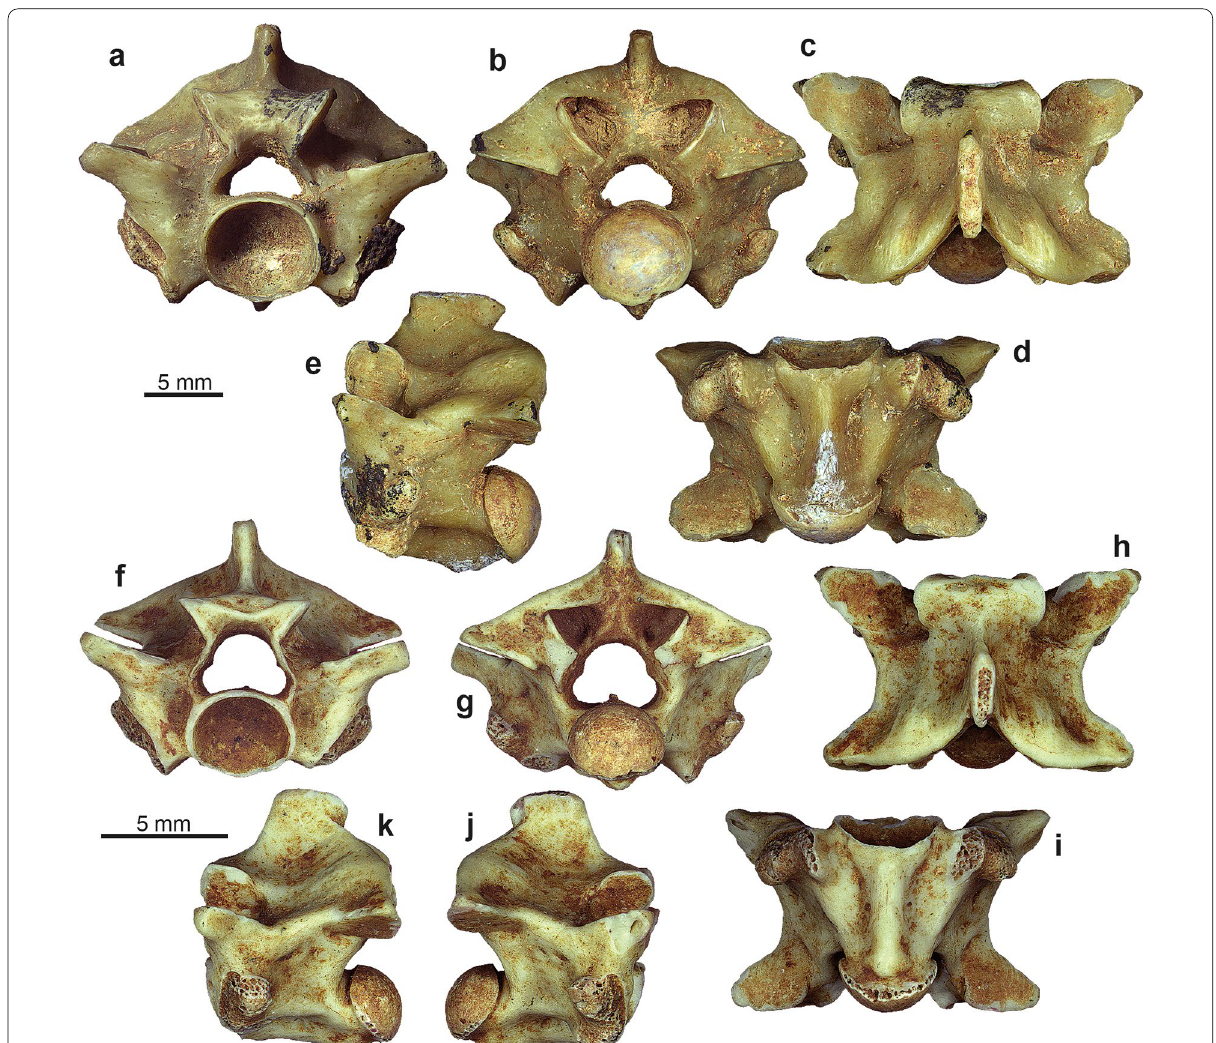
Fig. 91 Phosphoroboa filholii comb. nov. from imprecisely known locality(ies) in the Phosphorites du Quercy: a – e posterior trunk vertebra (NHMW 2019/0033/0002) in anterior ( a ), posterior ( b ), dorsal ( c ), ventral ( d ), and left lateral ( e ) views; f–k posterior trunk vertebra (NHMW 2019/0033/0127) in anterior ( f ), posterior ( g ), dorsal ( h ), ventral ( i ), right lateral ( j ) and left lateral ( k )